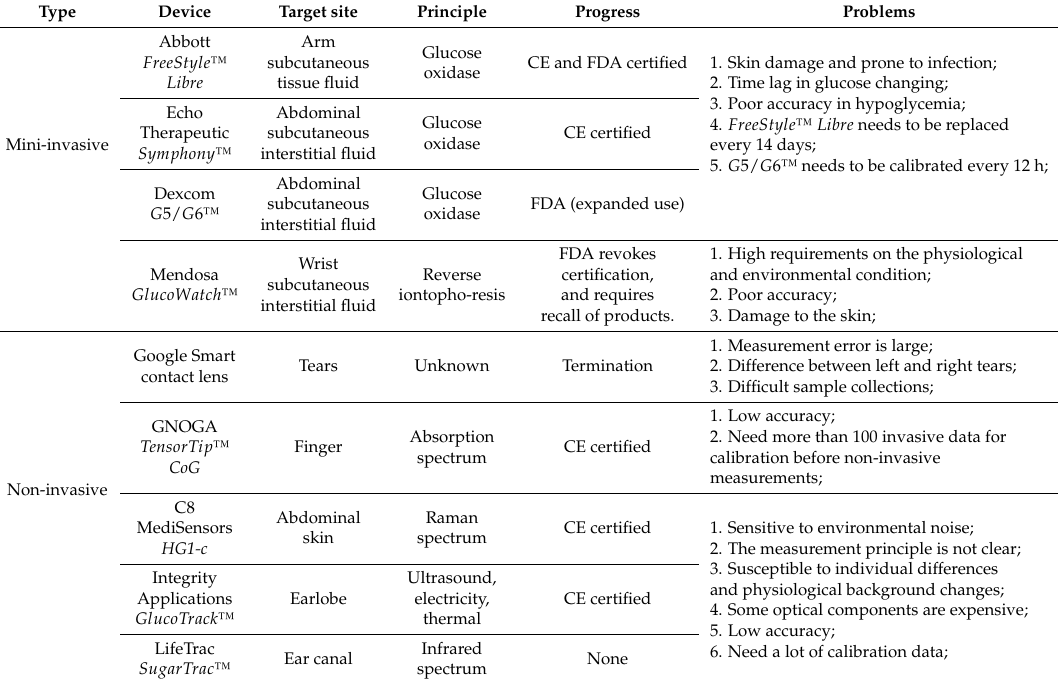
Table 1. Comparison and analysis of mini-invasive and non-invasive blood glucose meters. CE:Communate Europpene, FDA:U.S. Food and Drug